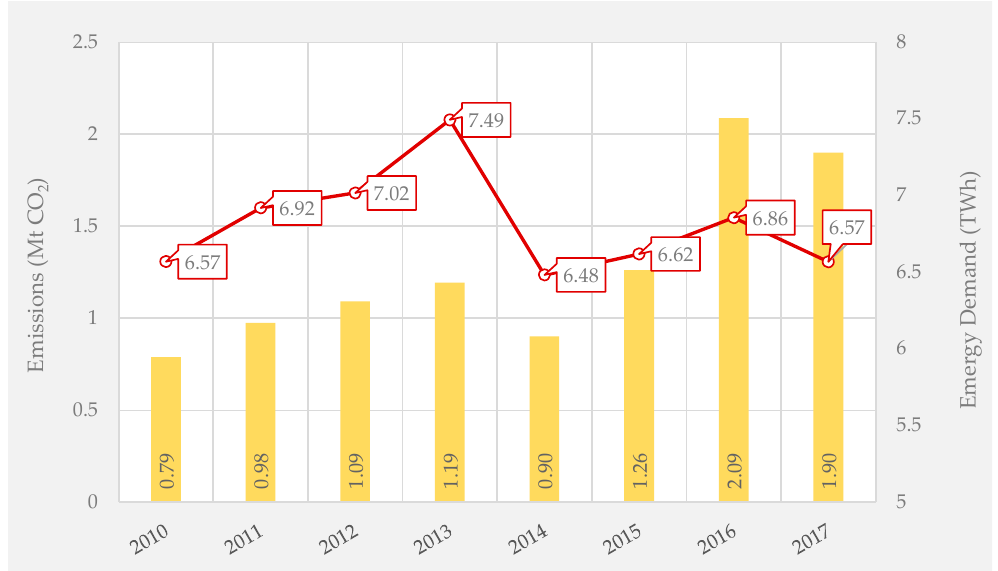
Figure 2. Development of CO 2 emissions (yellow bars) and energy demand (red line) of the pharma sector in Germany. Data source: Statistisches Bundesamt (Destatis), Genesis Online; data licence by-2–0 [6,7].